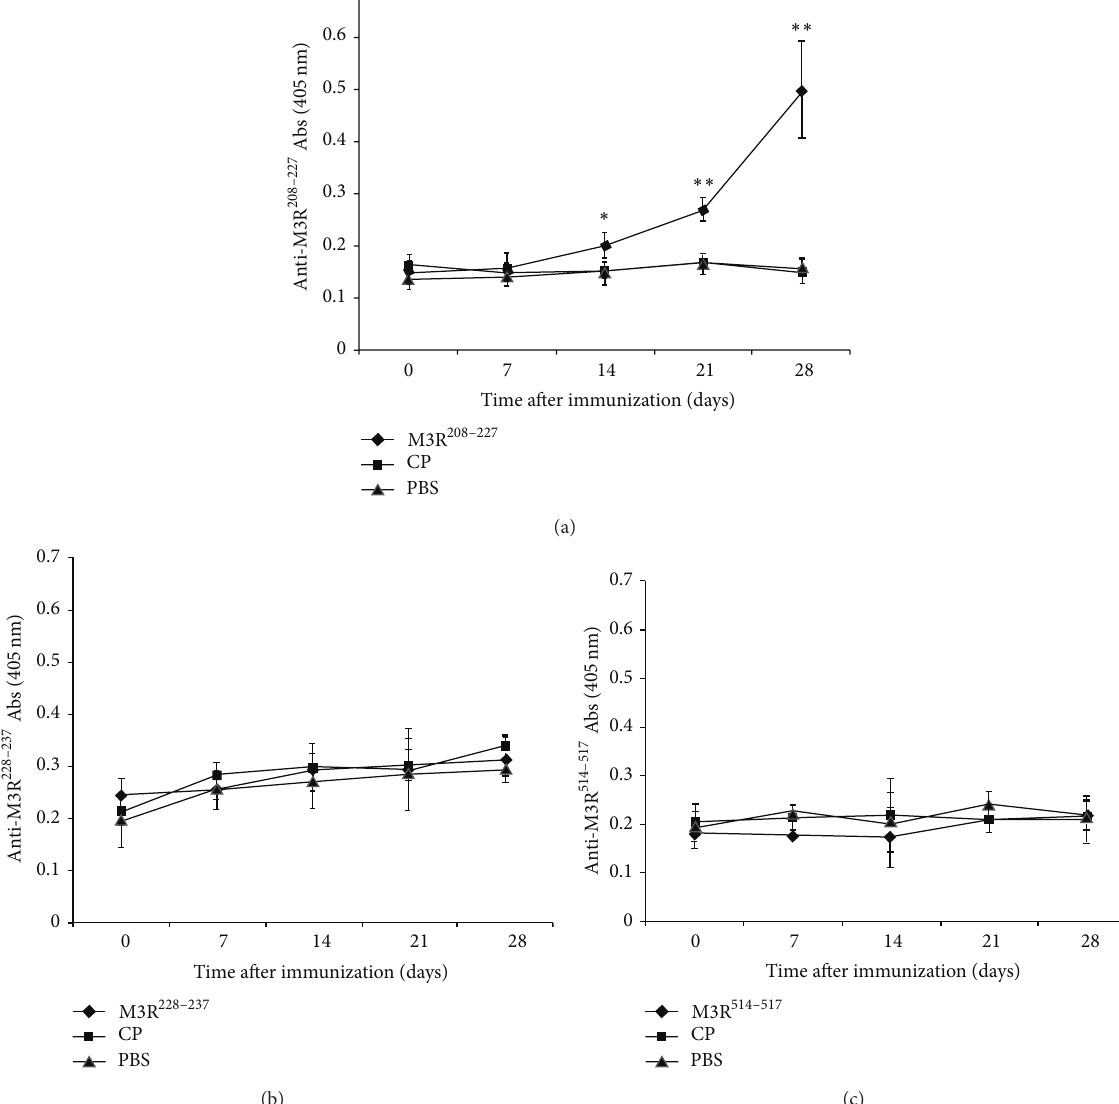
Figure 1: Immunization with the M3R 208−227 peptide induced peptide-specific antibodies. NOD/LtJ mice received 100 𝜇 g M3R 208−227